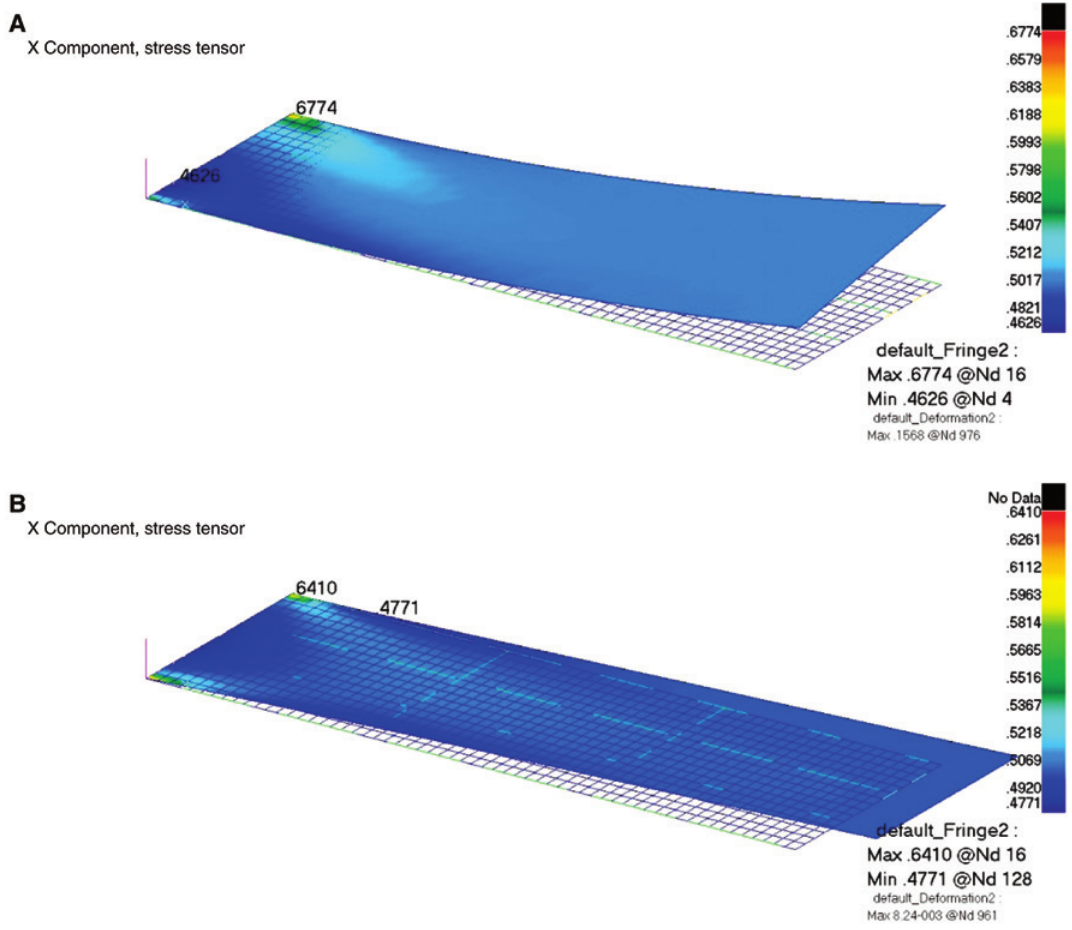
= 1 N/mm, deformed shape and stress contours, σ x